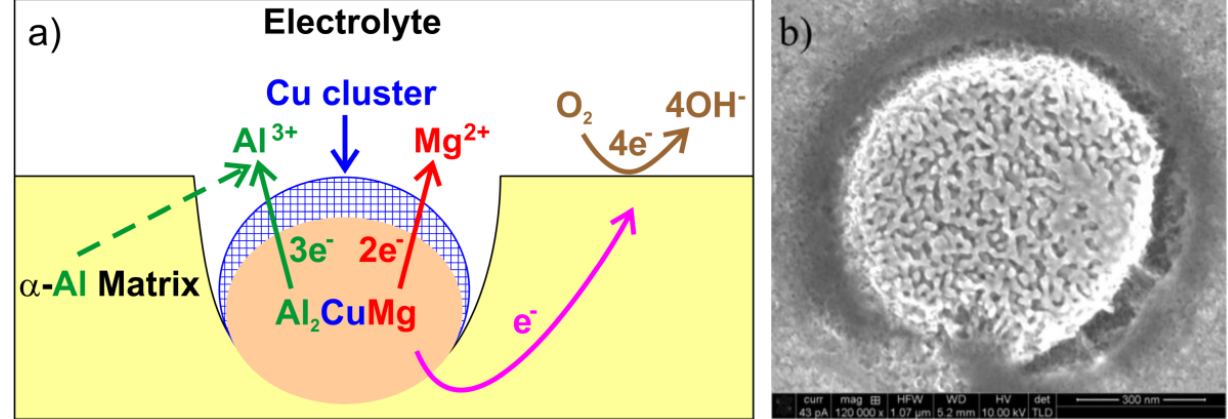
Figure 10. Schematic of trenching of Al 7 Cu 2 Fe intermetallic in AA2024-T3 aluminum alloy ( a ); microstructure image of corroded alloy surface after 1-h exposure in aerated H 2 O at 30 °C, redrawn ( a ) and reproduced ( b ) from ref. [76].